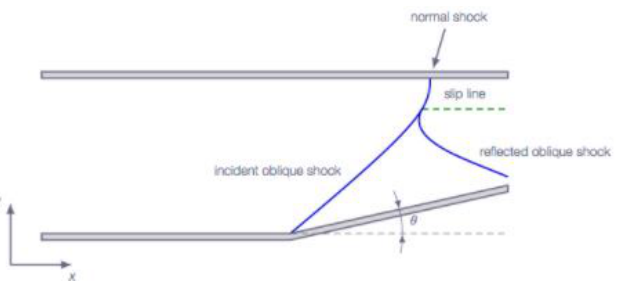
Figure 2. Incident and reflected oblique shocks and normal-shock approximation close to the wall.